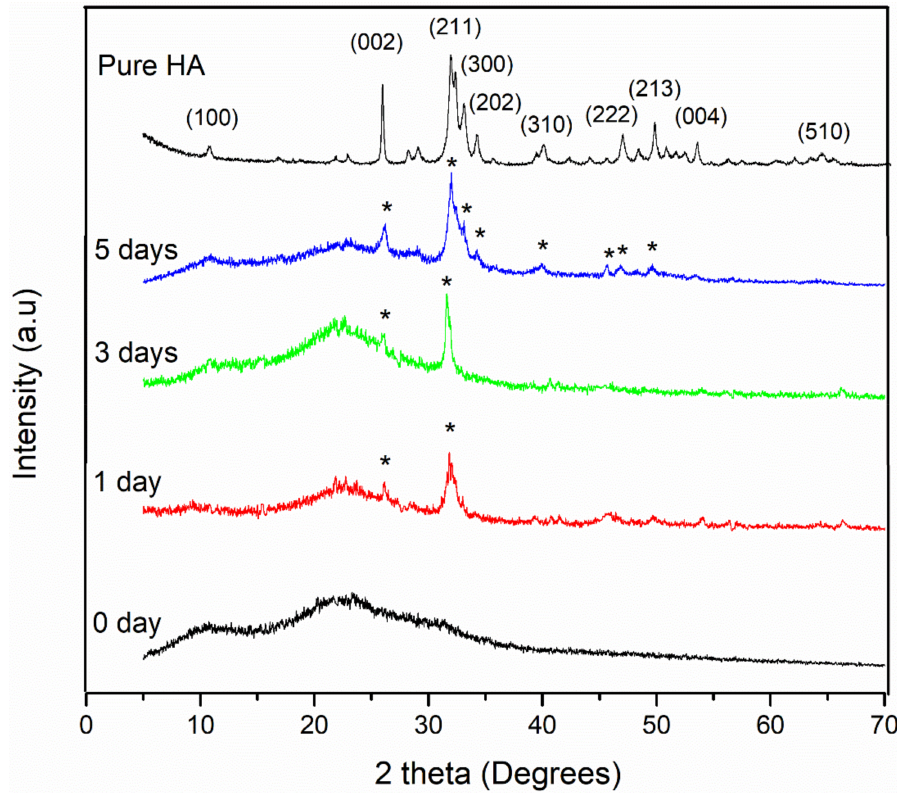
Figure 3. XRD diagrams of bioactive glass before and after the in vitro experiment in the